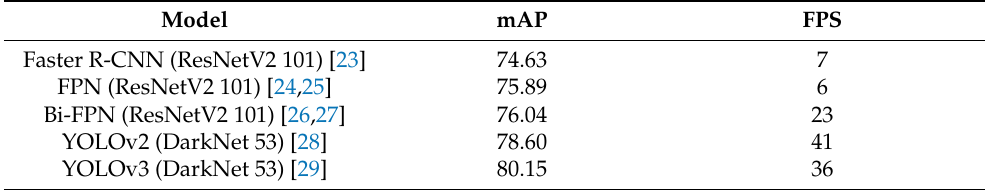
Table 1. A comparison of object detection models based on Pascal VOC 2007 dataset.